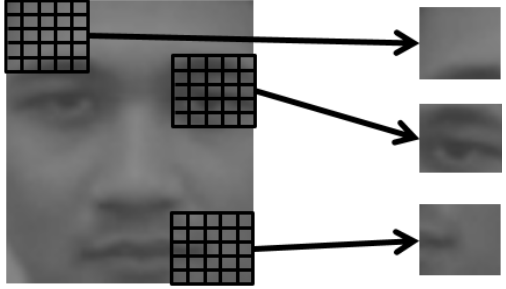
Figure 3. Examples of patches taken from a face